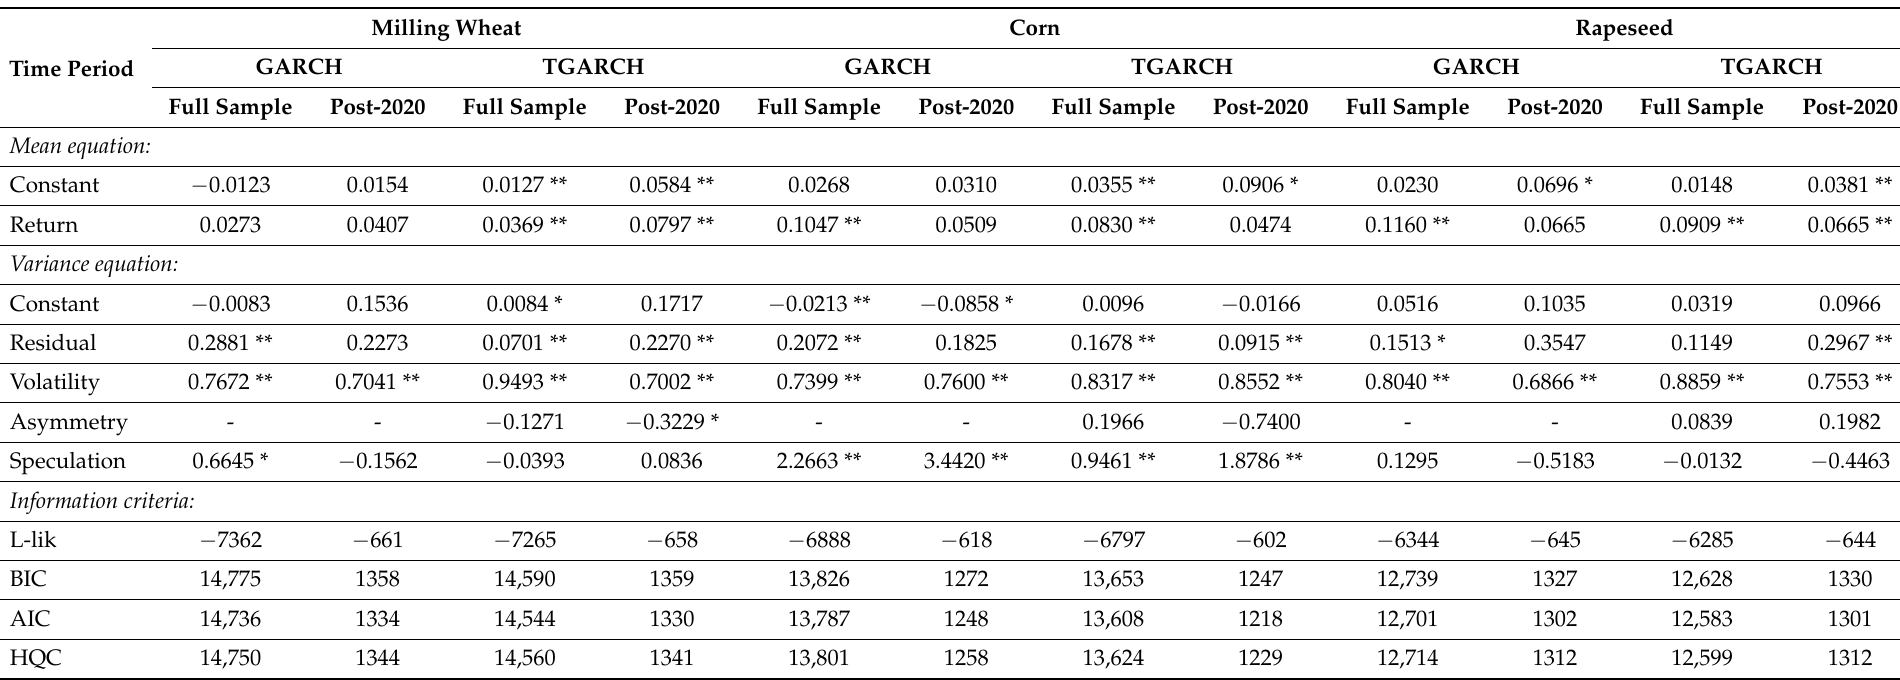
Table 5. Estimates of GARCH agricultural commodity-return models using Framework I without a month’s